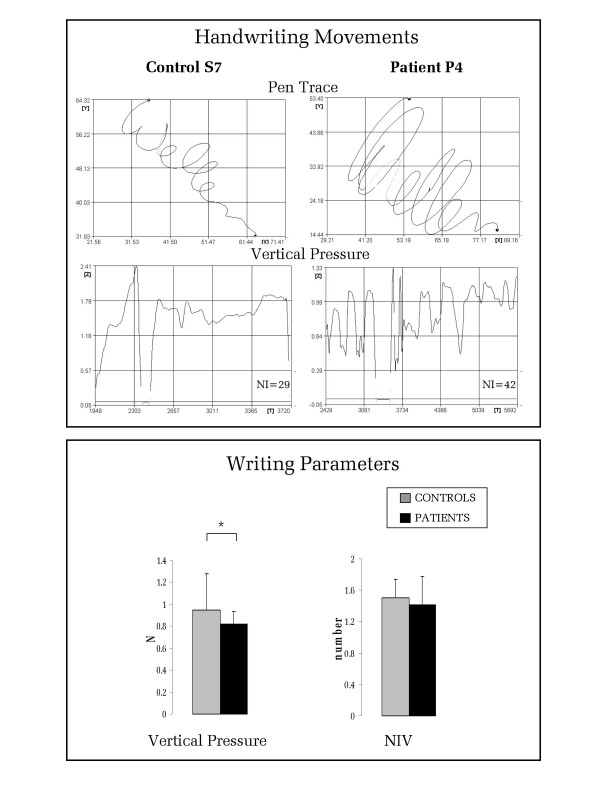
Original handwriting movements and writing parameters (vertical pressure and NIV). Upper panel: original data of handwriting movement during writing of the highly automated word "Wellen" from the sentence "Die Wellen schlagen hoch" for control subject S7 (left part) and writer's cramp patient P4 (right part). The upper plots represent the X/Y coordinate plot of the tip of the writing pen on the digitizing tablet. The lower plots are the respective time courses on Z-axis for the vertical pressure. Under each the number of inversions of vertical pressure is given (NI). The continuous line denotes the pen trace on the tablet and the dotted one – the pen trace lifted. Note in the pen trace that the patient has a longer stroke length and trajectory on the paper with longer pen lift. Note also that the time course pattern of the vertical pressure for the patient is characterized by larger number of segments with more NI and lower vertical pressure. Lower panel: mean group values and standard deviations (error bars) for 7 controls (grey column) and 7 patients (black column) for vertical pressure and number of inversions in velocity per stroke (NIV). The asterisk denotes a statistically significant difference between both groups (p < 0.05). Note the statistically significant lower vertical pressure for the patients.